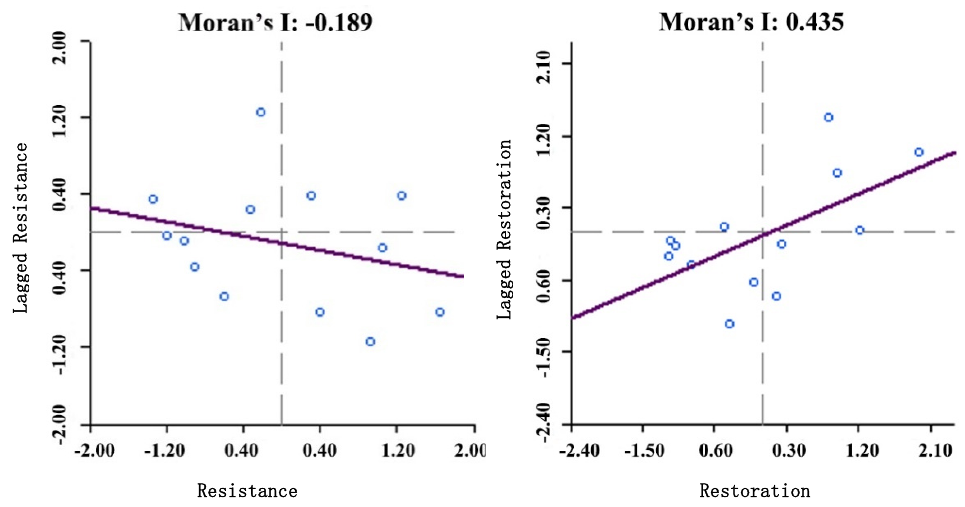
Figure 10. The global Moran’s I of resistance and restoration of the Beijing–Tianjin–Hebei urban Figure 10. agglomeration.